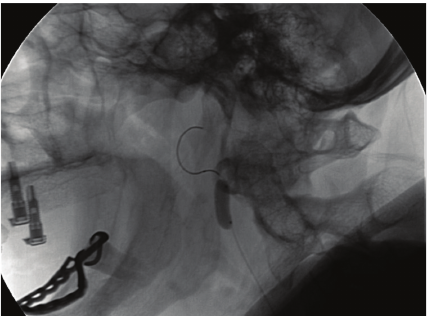
Figure 2: Balloon occlusion test reduced the pulsatile tinnitus almost